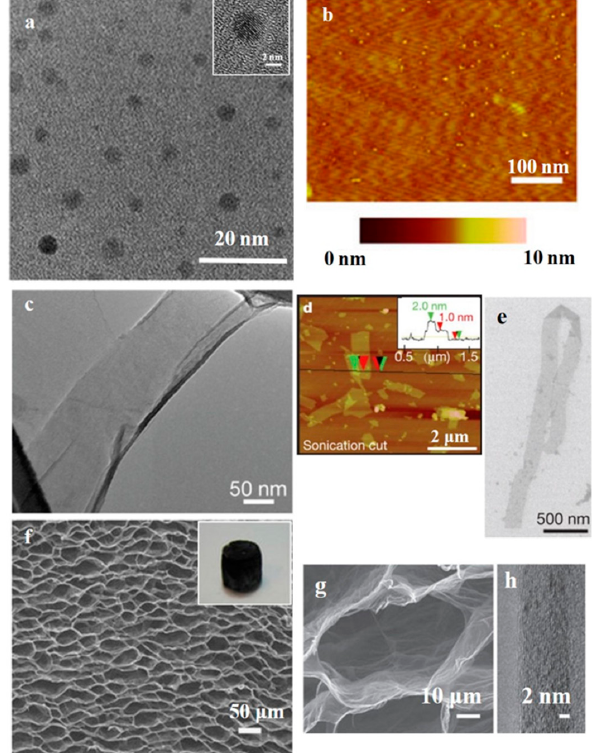
Figure 2. ( a ) TEM image and ( b ) atomic force microscopy (AFM) image of graphene quantum